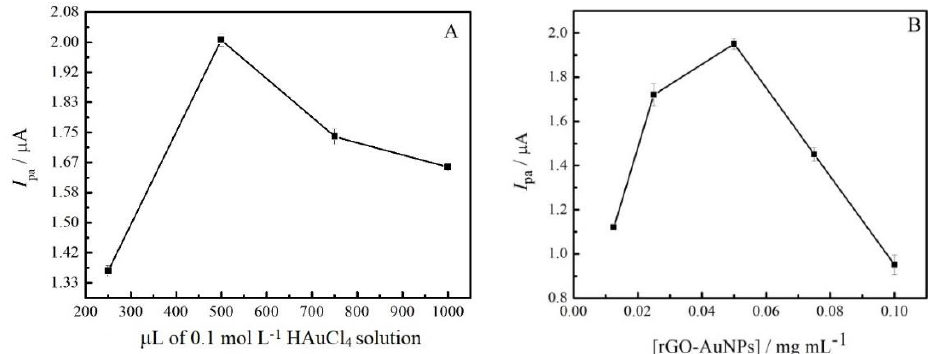
Figure 9. Optimization of the electrode composition using DPV in 0.2 mol L −1 PBS pH 8.0 containing 5.0 μmol L −1 of SMZ: ( A ) influence of the chloroauric acid amount in the